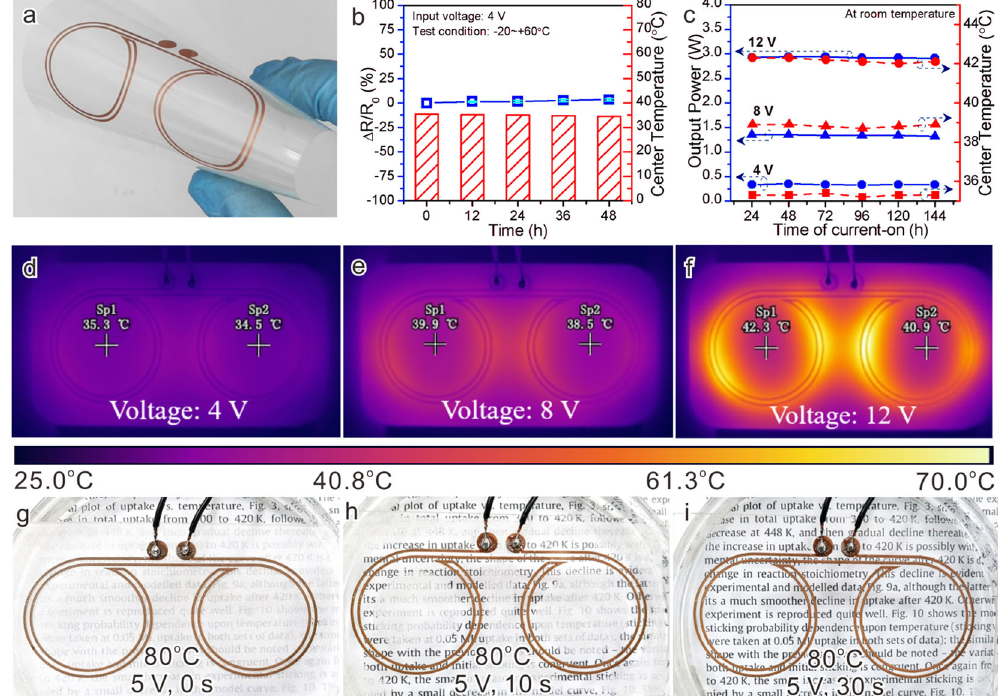
Fig. 5 Characterization of anti-fog fi lms. a Flexible pattern of screen-printed copper paste conductive circuits on PET substrates. b Cold and hot shock tests under 4 V input voltage. c Output power and steady-state center temperature of the electrothermal device as a function of power-on time. IR images of the electrothermal device under d 4 V, e 8 V, and f 12 V input voltage. g – i Optical images of copper electric heating fi lm, putting on 80 °C hot water with a distance of 5